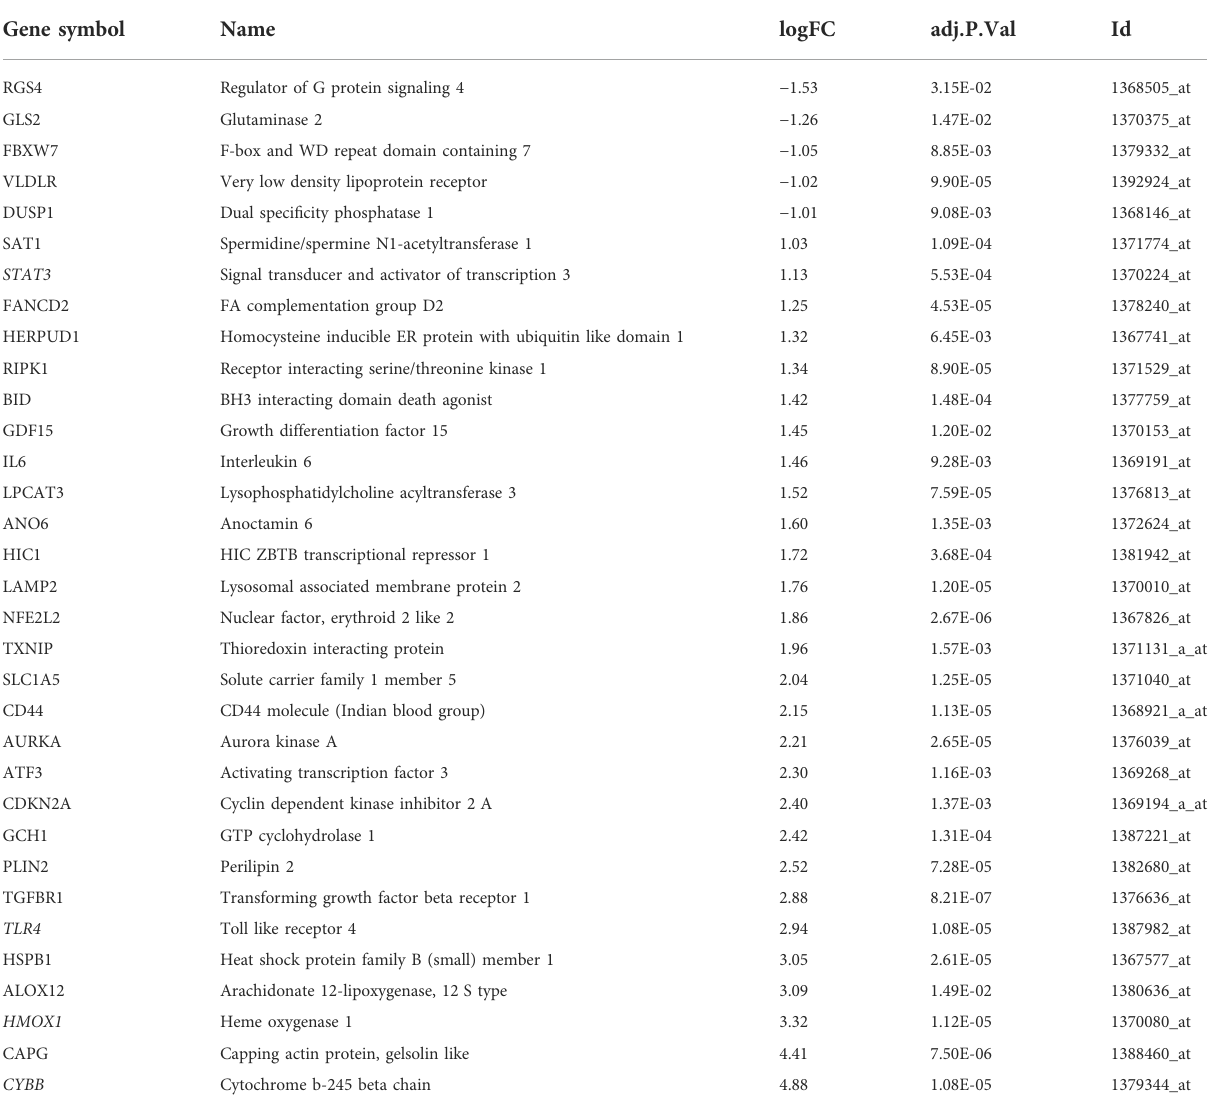
TABLE 1 Ferroptosis-related differentially expressed